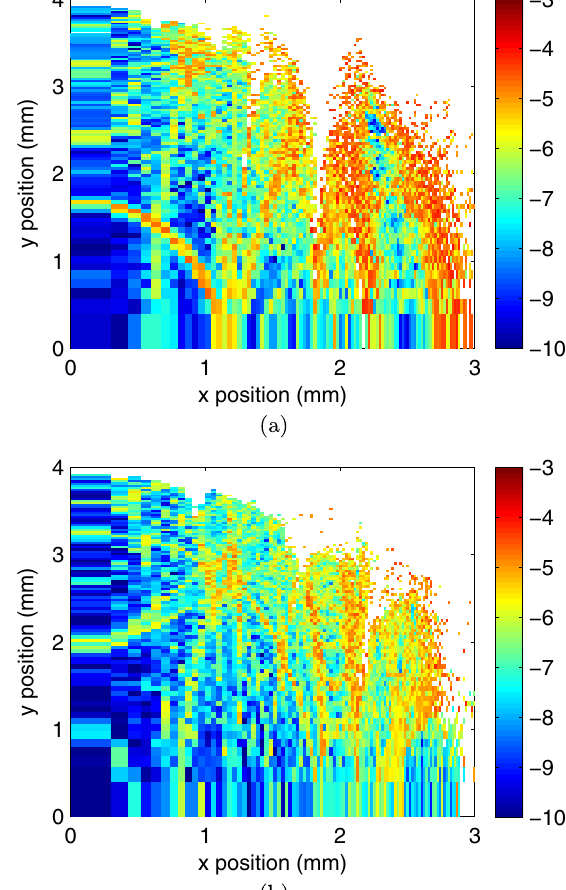
FIG. 7. Dynamic apertures and diffusion rates of lattice opti- mized using (a) dynamic aperture area as objective or (b) total diffusion rate as objectives. The diffusion rate of particle mo- tions is color coded in the plot. The blue color represents the particle is very stable, and the red color represents very chaotic.